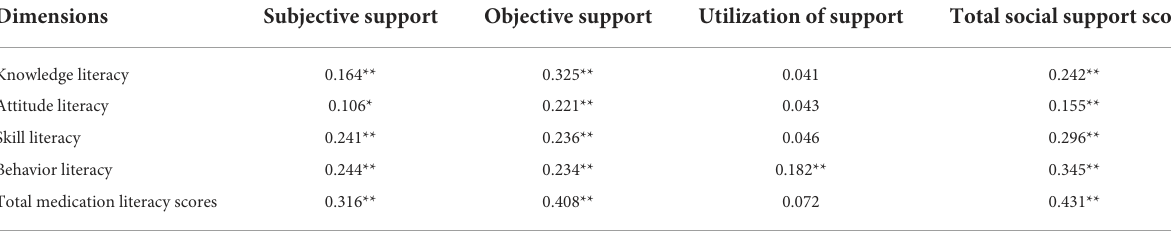
TABLE 2 Pearson correlation analysis between medication literacy and social support ( n = 362).